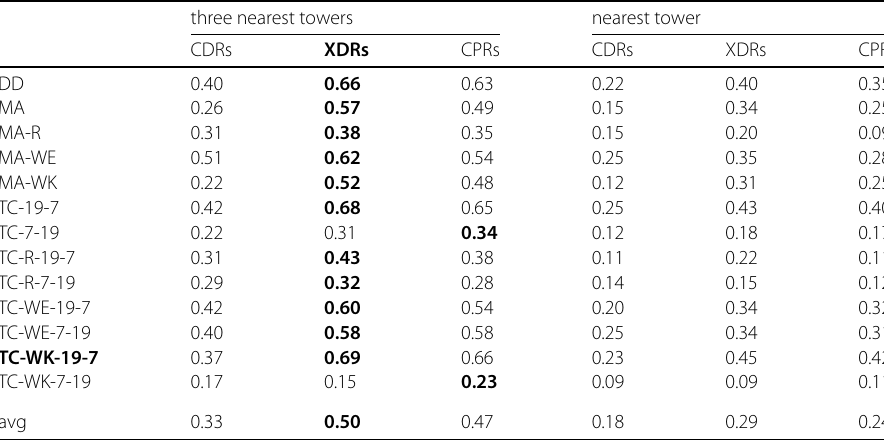
Table 4 Accuracy of each combination of HDA and stream three nearest towers nearest tower CDRs